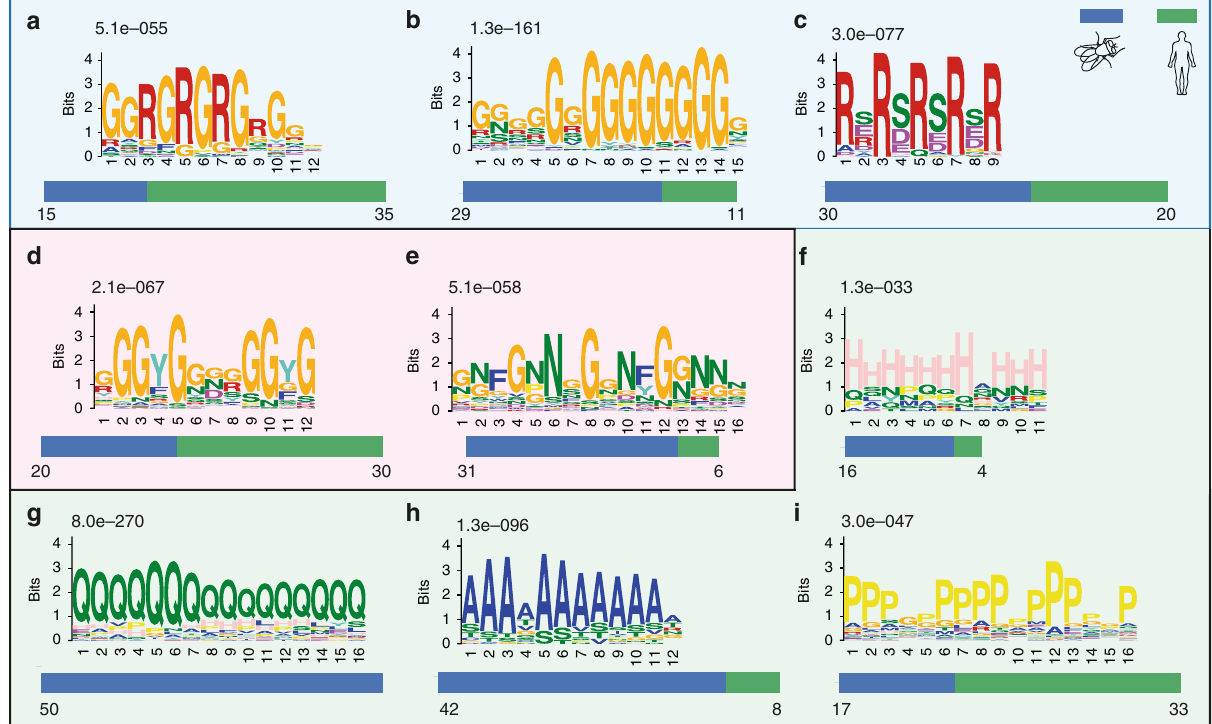
Fig. 9 Motif usage in IDRs of CAPRI-peptides. a – c Illustration of arginine-based motifs discovered by MEME analysis 57 in disordered regions of Drosophila and human ADJ-peptides. E -values displayed on top of each motif are calculated by the MEME tool and number of sites ( n ) are shown for each of the motifs. The number of sites observed in each of the species are represented as bars below each motif. The maximum number of sites allowed for motif construction is 50 (see Methods for details). d – e As in a for aromatic amino acid (Y or F)-based motifs discovered in both Drosophila and humans. f – i As in a for repetitive single amino acid-based motifs discovered in both Drosophila and